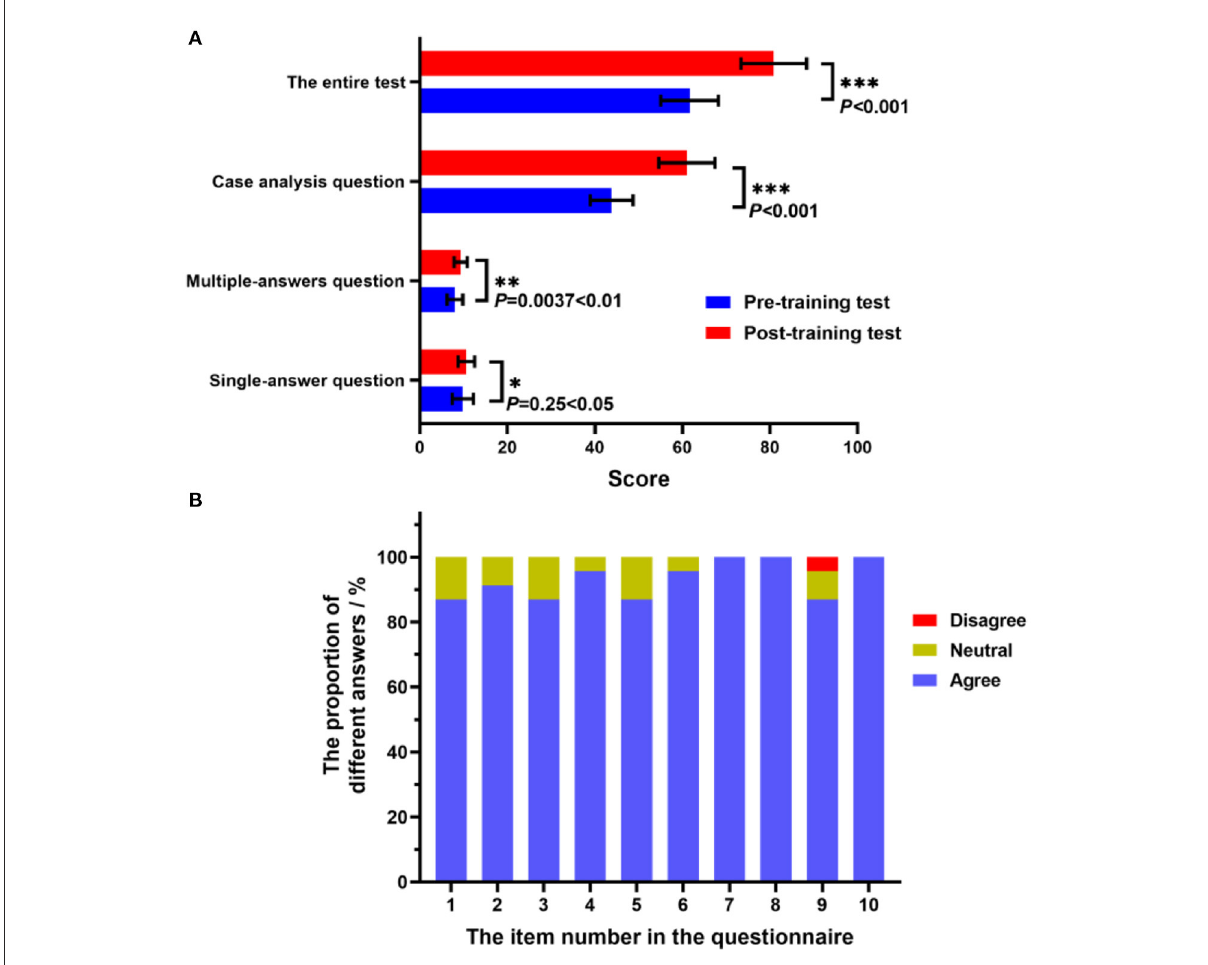
FIGURE2 Analysis of pre- and post-training test score and questionnaires. (A) The total score and the scores of each question type before and after training. * P < 0.05, ** P < 0.01, ** P < 0.001 vs Pre-training test. (B) The percentage of each option for every item in